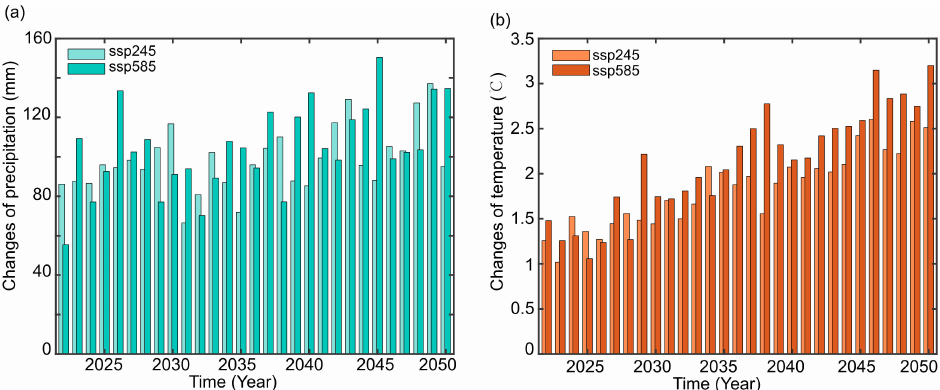
Figure 7. Changes in annual ( a ) precipitation and ( b ) temperature under future climate scenarios SSP245 and SSP585 in the headstream of the Tarim River Basin compared with the values in the reference period from 1957 to 2017.